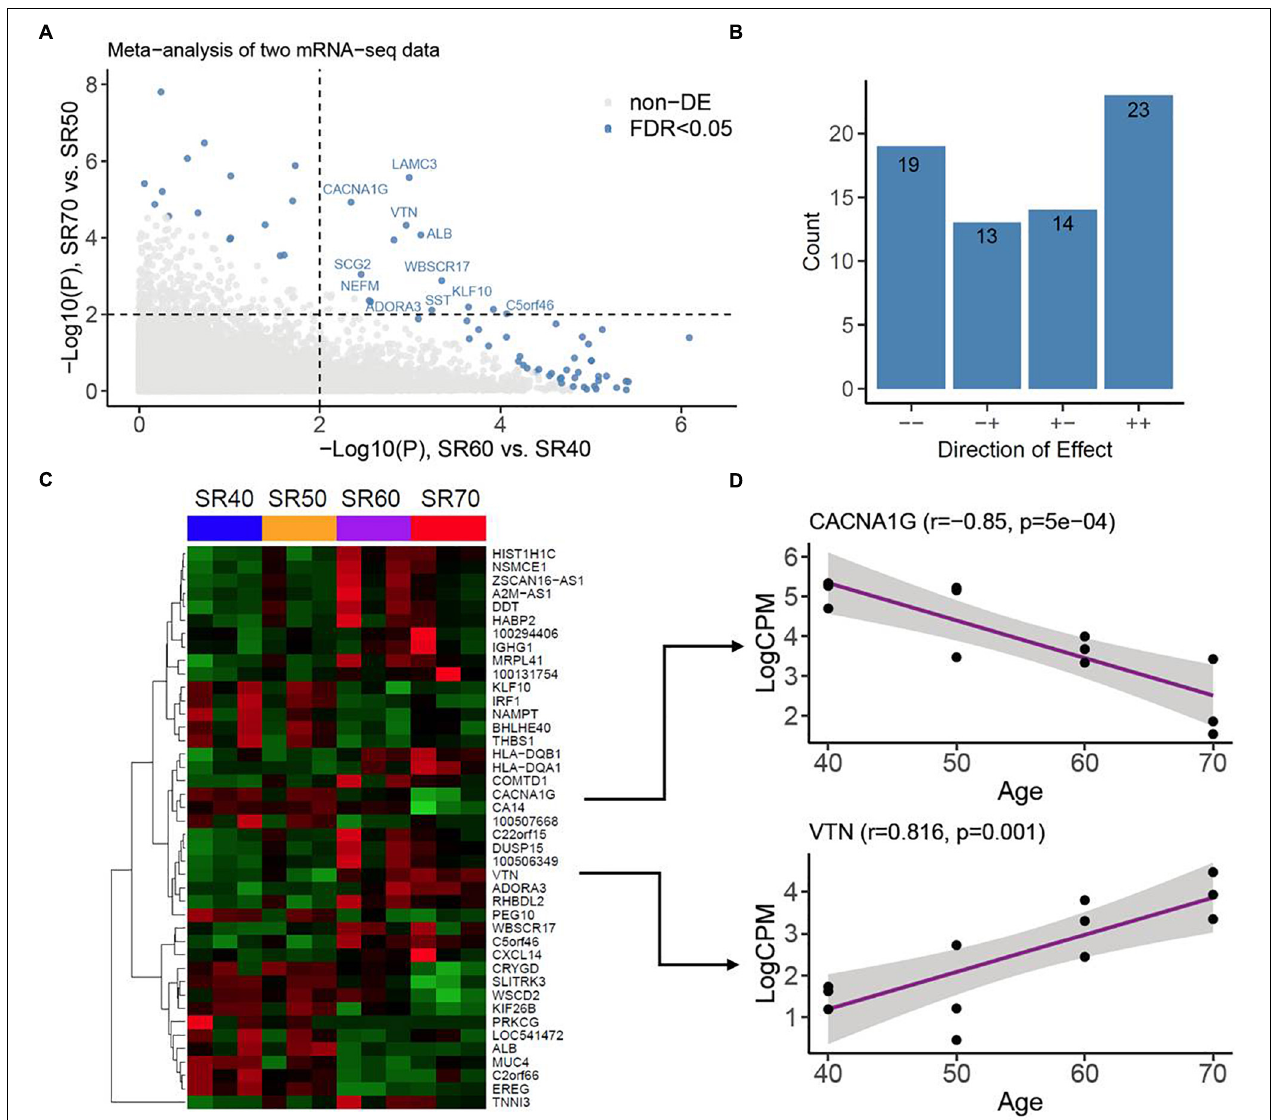
FIGURE 3 | mRNA-seq analysis of human atrial samples. (A) Meta-analysis of two mRNA-seq datasets. X -axis, − log10 ( P value) calculated from differential analysis between SR60 and SR40. Y -axis, − log10 ( P value) calculated from differential analysis between SR70 and SR50. Dots with steel blue color indicate genes (or mRNAs) significantly associated with human AA at FDR < 0.05. (B) Counts of genes with opposite ( − + and +) and consistent effects ( − and ++). (C) Heatmap and hierarchical structure of 42 AA-associated genes across 12 human atrial samples. Each row indicated a gene, its Entrez ID or official symbol was shown at right side. (D) Examples of top-ranked genes ( CACNA1G and VTN ) showing strong linear trends with human age. Pearson Correlation coefficient ( r ) and the corresponding P value were shown at the